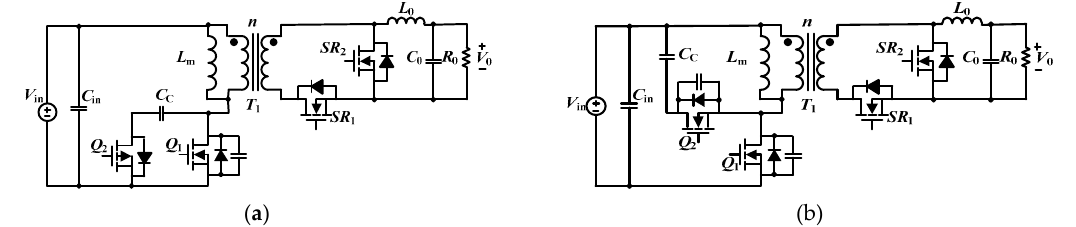
Figure 1. Two types active clamp forward converter: (a) with low-side clamped; (b) with high-side clamped.